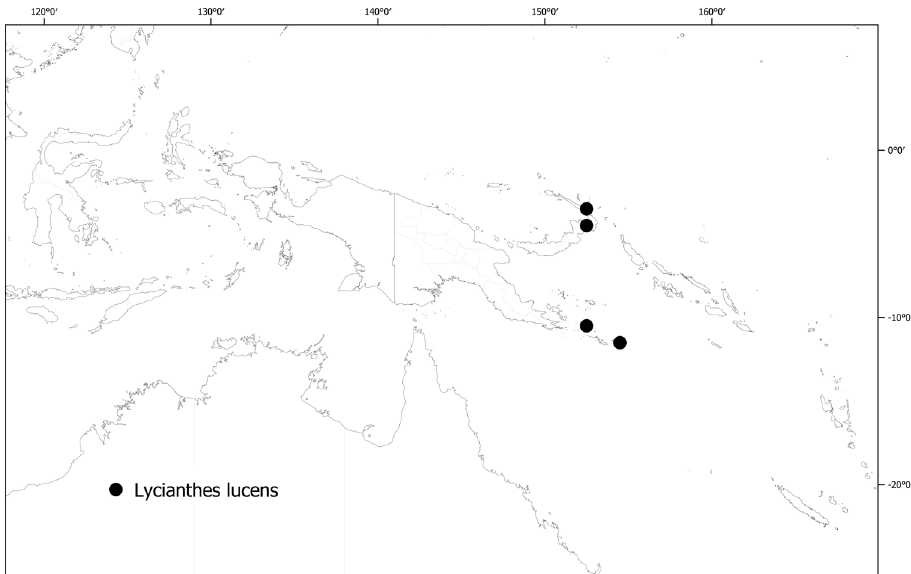
Figure 30. Distribution of Lycianthes